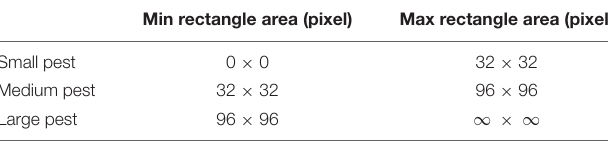
TABLE 3 | Definition of the small, medium, and large pests.